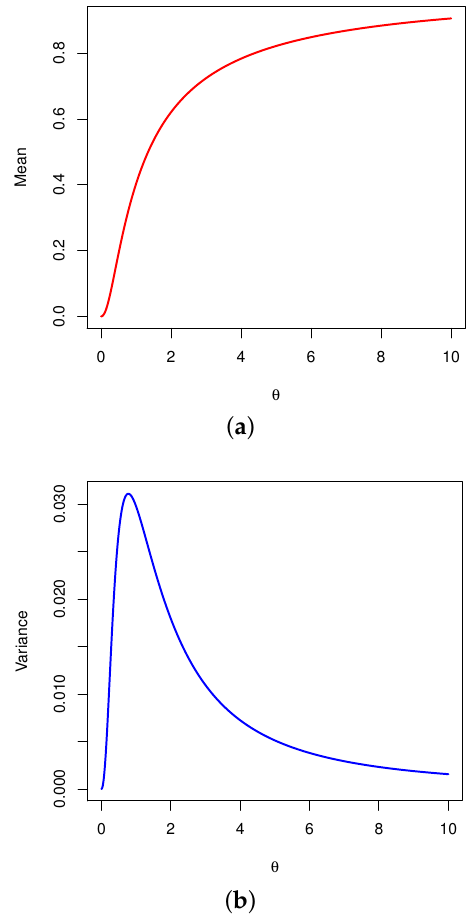
Figure 3. Plots of the ( a ) mean and ( b ) variance of the UTD for varying values of the parameter θ